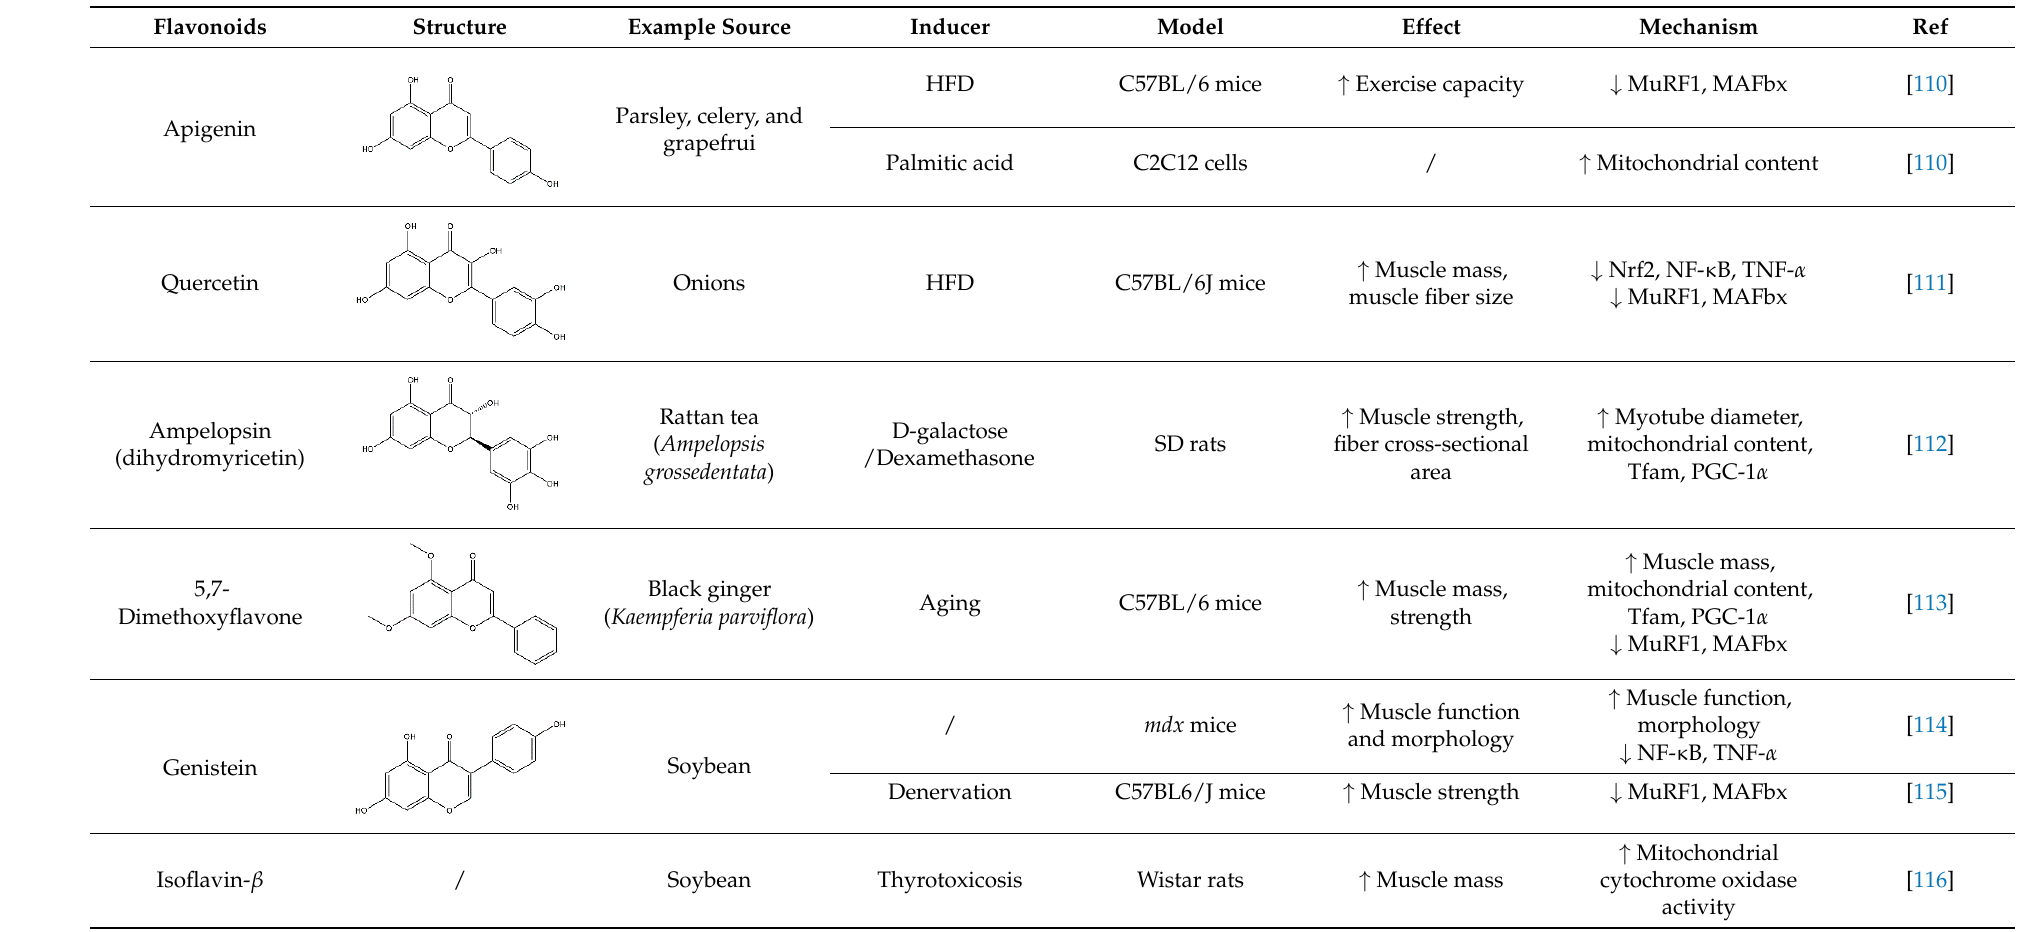
Table 6. Flavonoids in the prevention of the muscle atrophy in vitro/vivo.